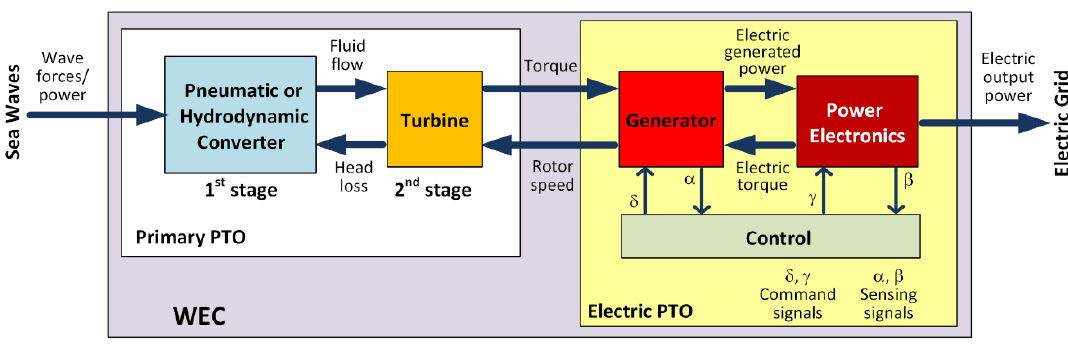
Figure 4. Wave-to-wire model of a wave energy converter.